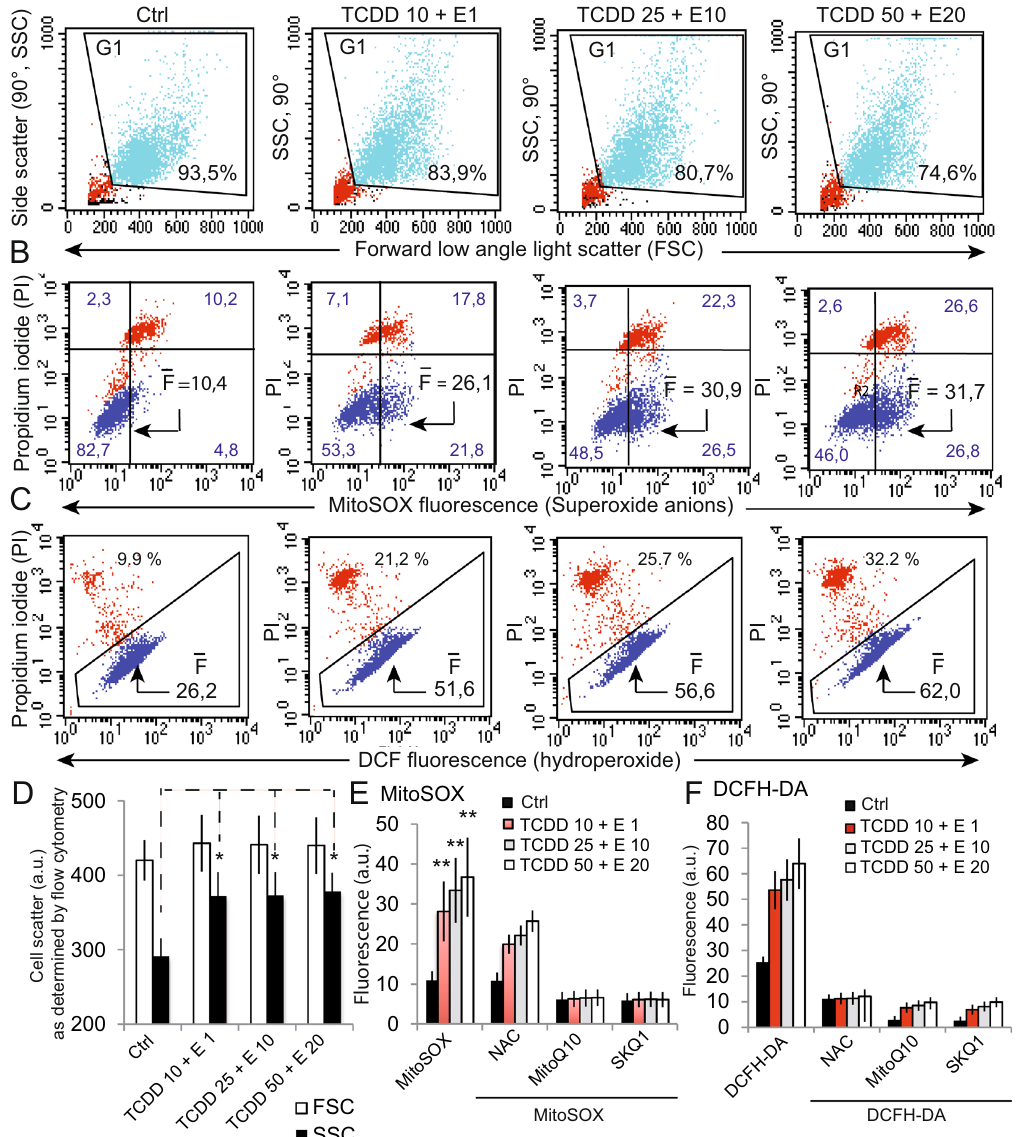
Figure 6. Light scattering properties and ROS production of Caco-2 cells treated with different concentrations of the pollutant mixture TCDD + E. ( A ) Changes in light scattering (i.e forward low angle light squatter, FSC and side squatter, SSC) of Caco-2 cells treated 48 h with different mixtures of TCDD + E. Percentages (%) indicate the amount of cells selected on FSC/SCC that are not debris (red dots at the bottom left part of the histograms) or aggregates. ( B ) Biparametric analyses of cells selected in the gate G1 on the light scatter ( A ), for the MitoSOX fluorescence (superoxide anion production) versus propidium iodide (PI) staining (taken as plasma membrane permeability and/or cellular viability). F bar (mean fluorescence value) indicates the mean fluorescence of the population in blue (viable cells) whereas the other values (4) are the percentage of cells in each quadrant. Red dots represent PI positive non-viable cells. ( C ) Biparametric analyses of the cells selected in the gate G1 on the light scatter ( A ), for the 2 HDCF-DA staining and the DCF fluorescence (H 2 O 2 production, in blue) versus propidium iodide (PI, in red) staining (taken as plasma membrane permeability and/or cellular viability). F bar indicates the mean fluorescence of the population in blue that increases upon treatments. The percentage of cells that are non-viables (PI positives) is indicated in % (red dots). ( D – F ) The histograms represent statistical analyses of the above A, B and C measurements respectively concerning in ( D ) the light scattering properties ( * P < 0,5), in ( E ) the superoxide anion generation with MitoSOX staining and in ( F ) the hydroperoxide measurements with DCFH-DA staining. Means of 7 independent experiments are presented (n = 7). In ( E ) and ( F ) respectively, MitoSOX and DCFH-DA measurements have also been realized in presence of three different antoxidants, i.e., N-acetylcystein (NAC) as a cytoplasmic anti-oxidant and two mitochondrially targeted antixoxidants which are MitoQ10 and SKQ1. (all data are means of 6 independent experiments, n =